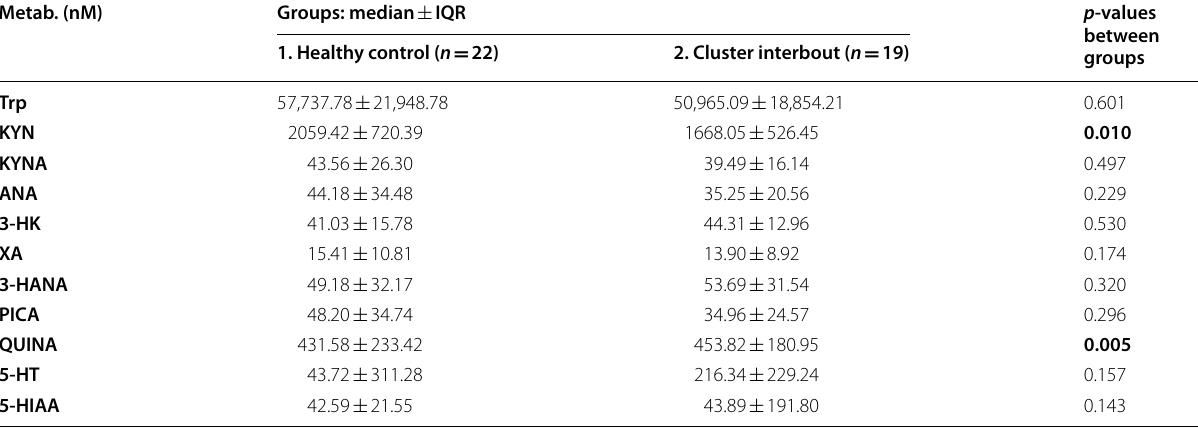
Significant differences were revealed between control and interbout data in cases of KYN and QUINA IQR interquartile range, Metab metabolites, Trp Tryptophan, KYN L-kynurenine, KYNA Kynurenic acid, ANA Anthranilic acid, 3-HK 3-hydroxikynurenine, XA Xanthurenic acid, 3-HANA 3-hydroxianthranilic acid, PICA Picolinic acid, QUINA Quinolinic acid, 5-HT 5-hydroxytryptamine, 5-HIAA 5-hydroxiindoleaceticacid